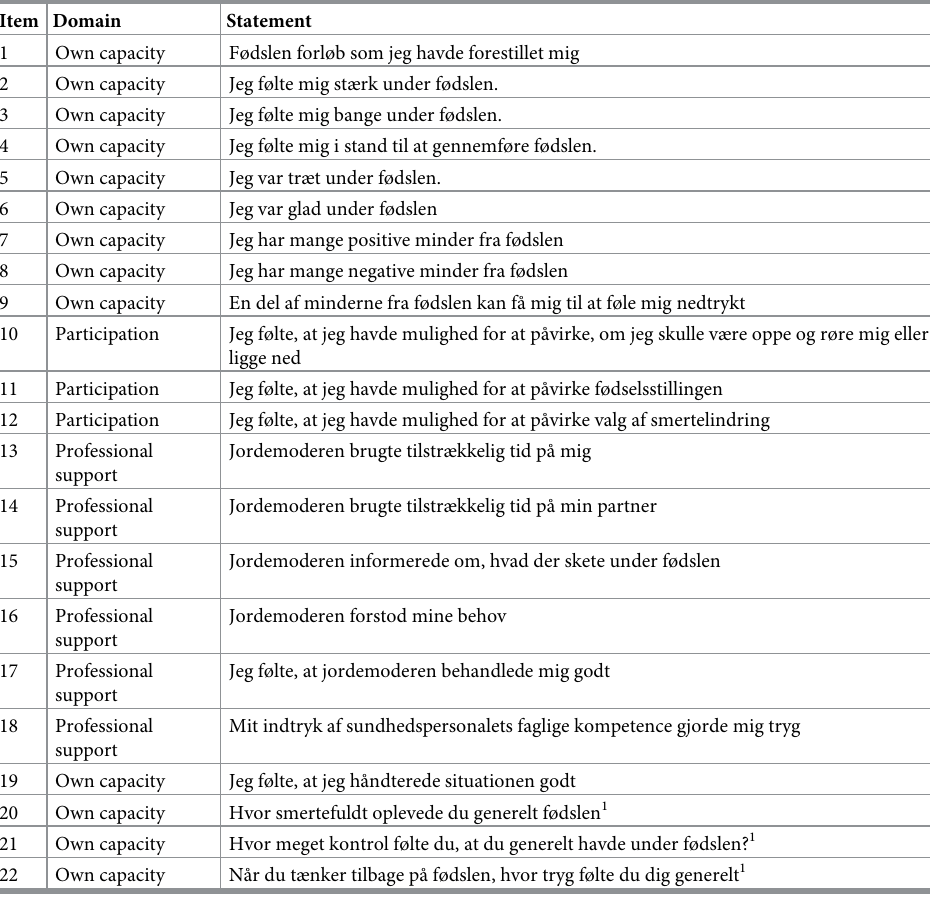
Table 1. The final version of the Danish Childbirth Experience Questionnaire, CEQ. Item